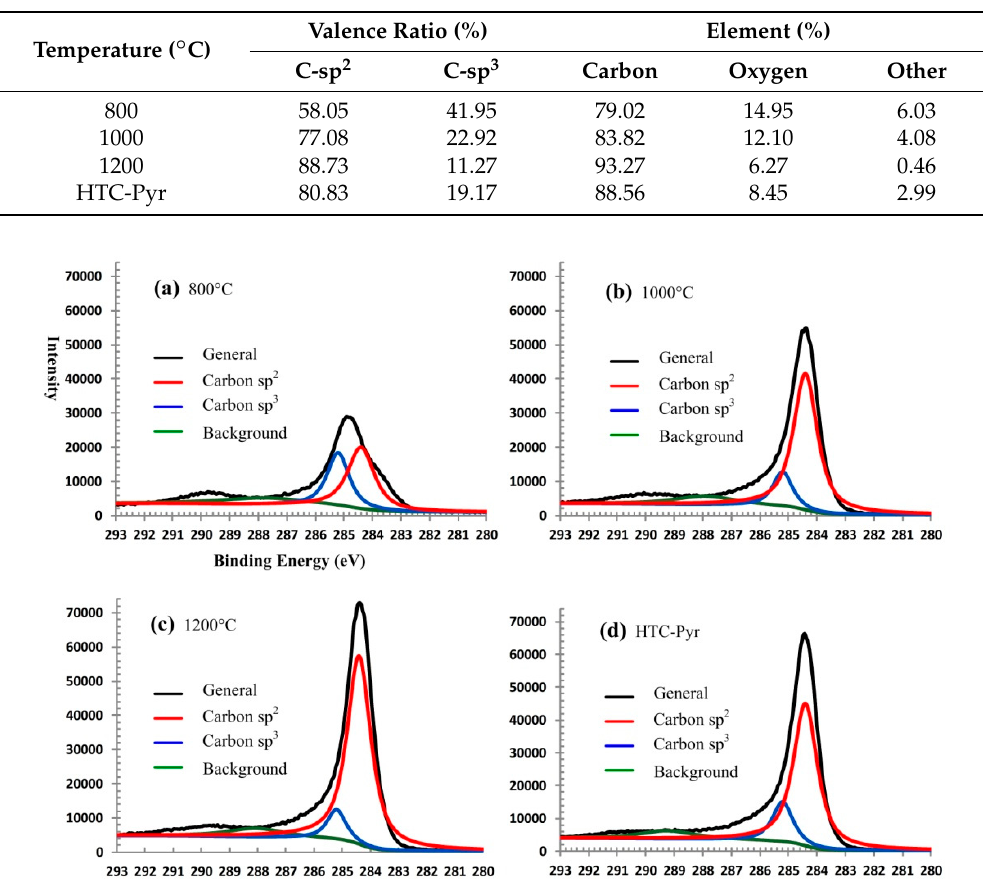
Table 1. The sp 2 to sp 3 ratio of carbon atoms and the elemental ratio in graphene microcrystal samples.